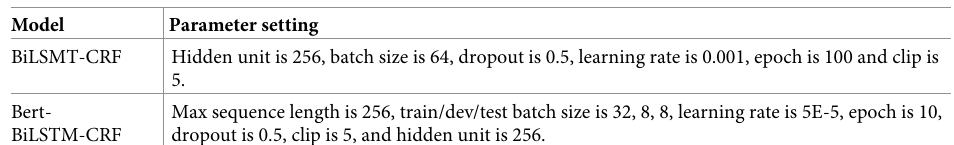
Table 1. Model parameter